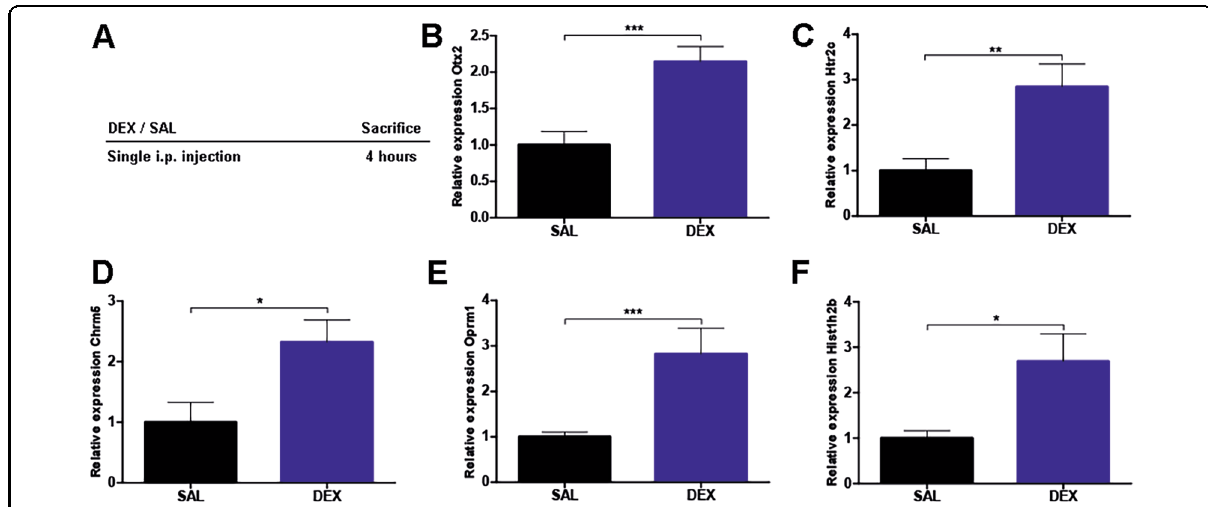
Fig. 5 Response-associated genes are regulated by glucocorticoid receptor activation. A Schematic overview ( n = 22). B – F qPCR of murine dentate gyrus samples revealed statistically signi fi cant upregulation of 5 genes ( T test or Mann – Whitney test). B Otx2 : t = 4.1, df = 18, p = 0.0006. C Htr2c : t = 3.3, df = 20, p = 0.0040. D Chrm5 : t = 2.7, df = 14, p = 0.0182. E Oprm1 : U = 3.0, p = 0.0003. F Hist1h2b : t = 2.8, df = 15, p = 0.0125.